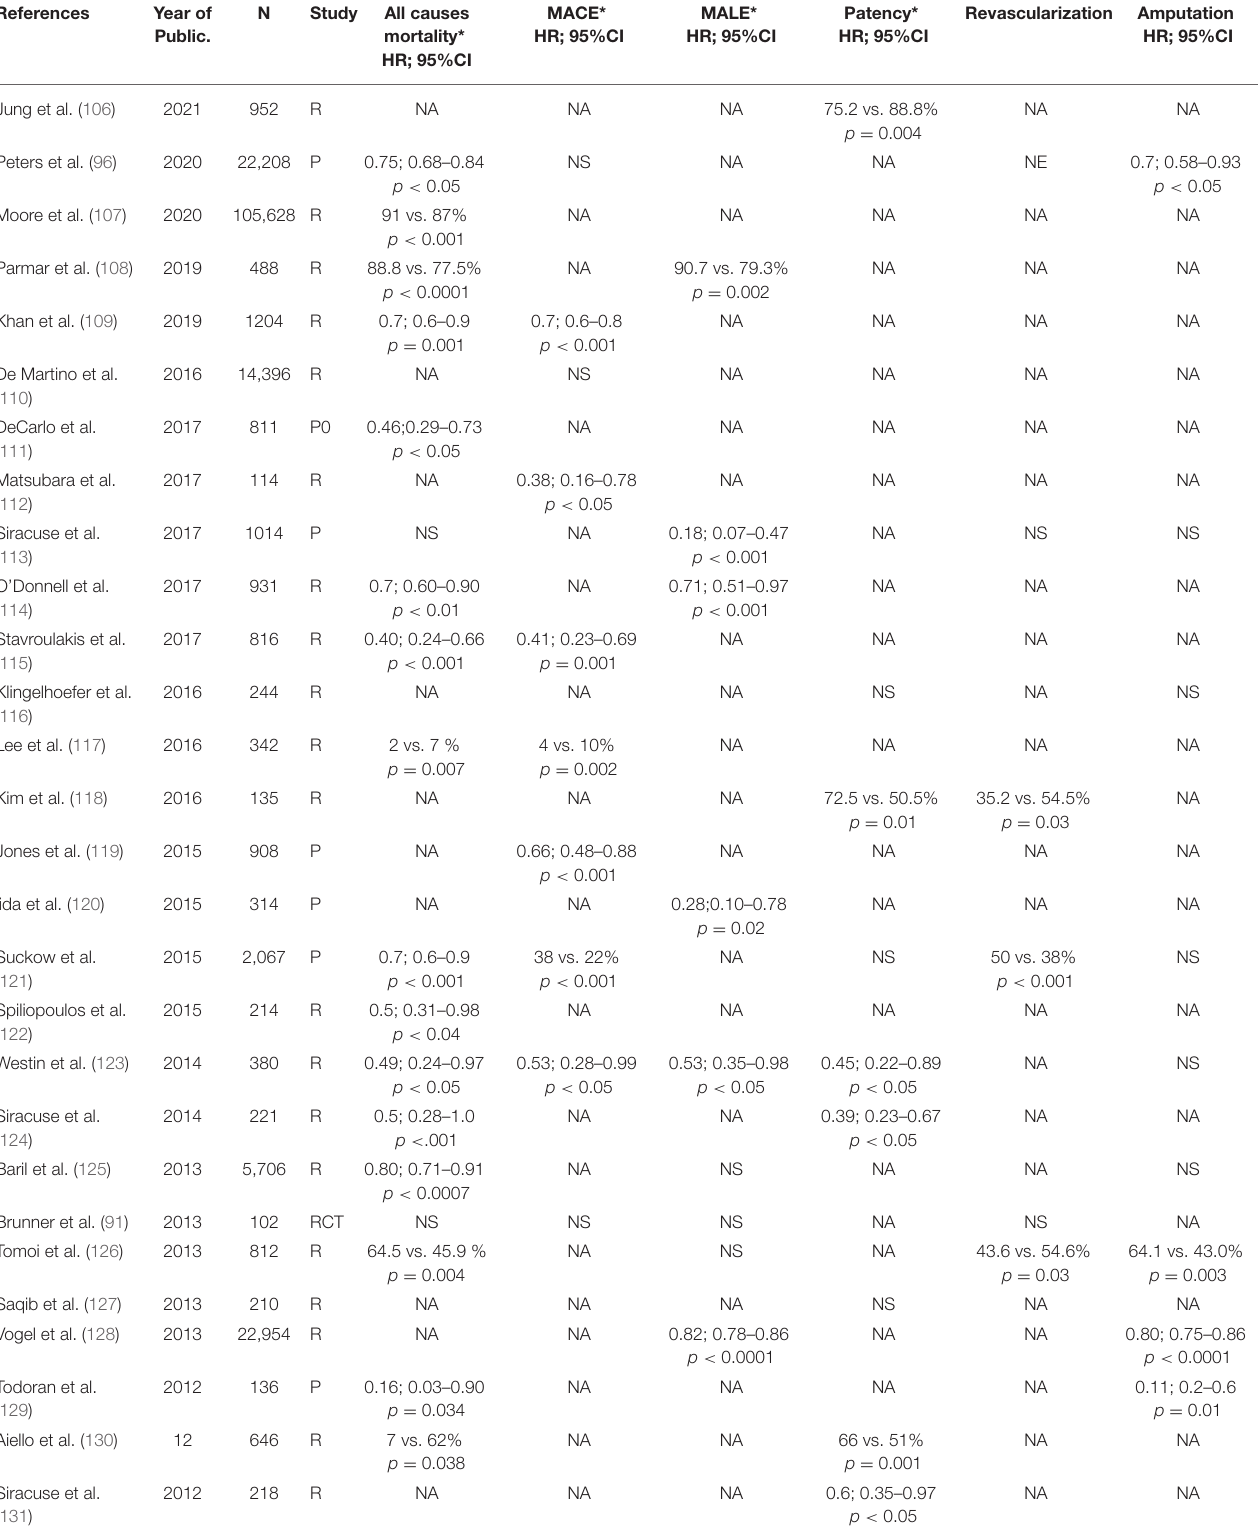
TABLE 2 | Benefits of statins in patients with advanced stages of PAD (CLI or undergoing